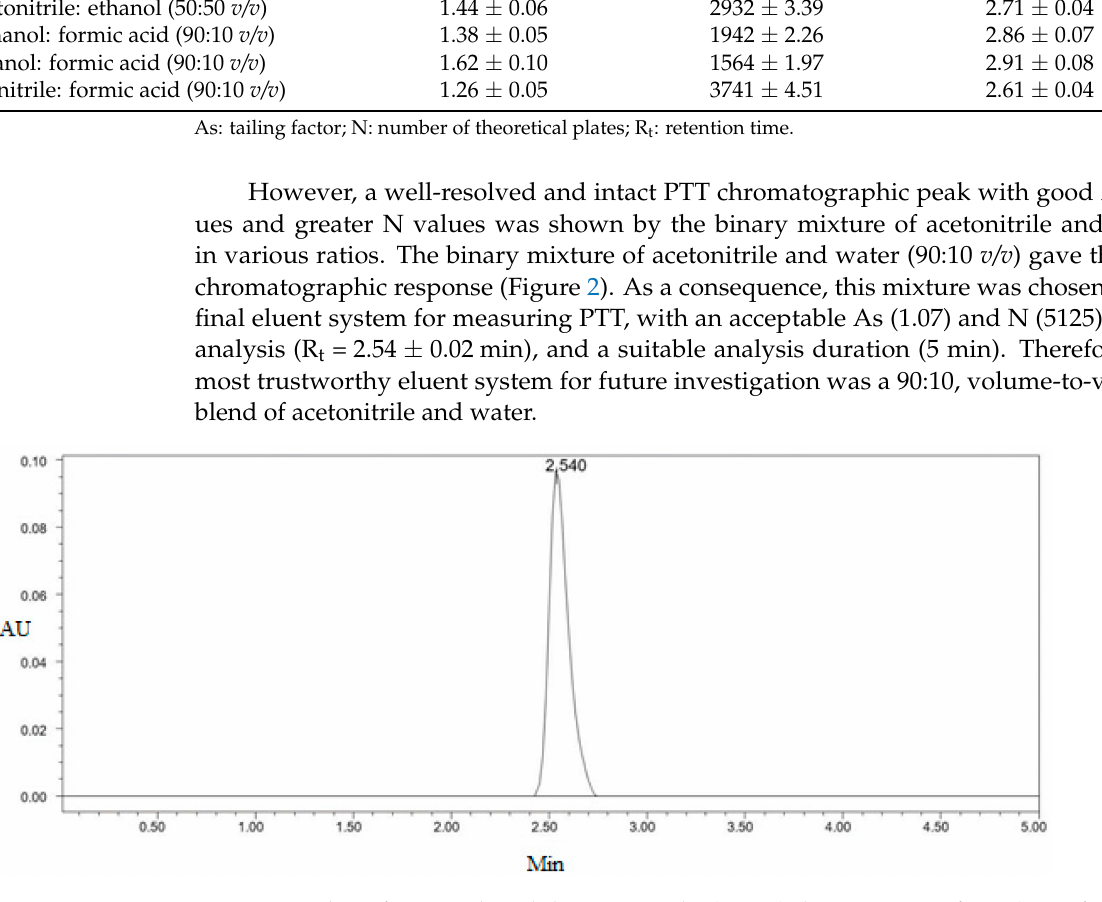
Figure 2. High-performance liquid chromatography (HPLC) chromatogram of PTT (10 µ g/g concen- tration) in solution, produced using a binary eluent system that consisted of acetonitrile and water (90:10 v/v